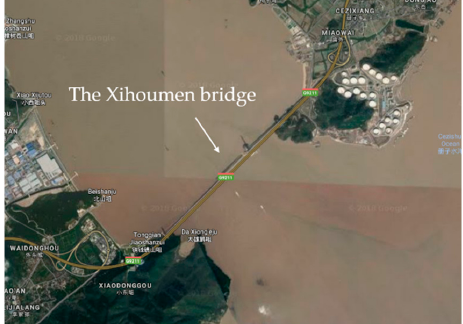
Figure 10. Elevation of XHM Bridge.